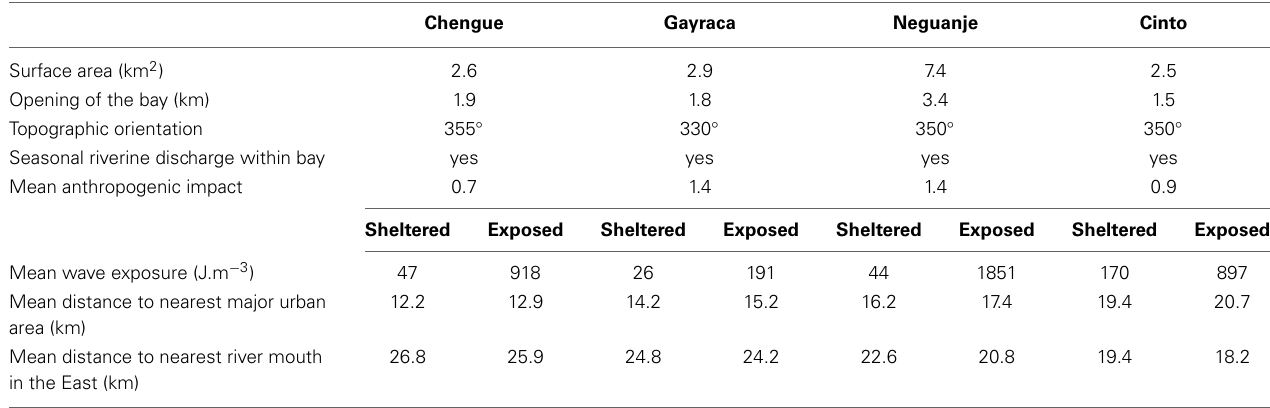
Table 1 | Properties of investigated bays and study sites in TNNP. Chengue Gayraca Neguanje